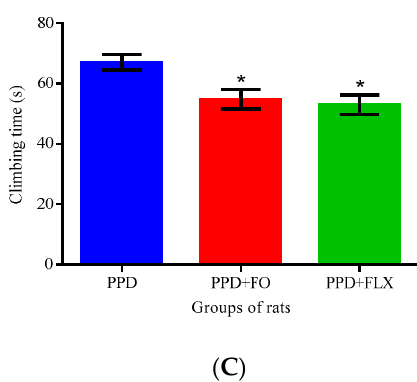
Figure 3. Effect of FO on Forced swimming test in PPD rats. ( A) —Immobility time. ( B )—swimming time and ( C )—climbing time. Data presented as mean ± SEM, n = 6, * p < 0.05 vs. PPD. (PPD—postpartum depression-like, FO—fish oil, FLX—fluoxetine). Dunnett’s post hoc test was used for the comparisons.